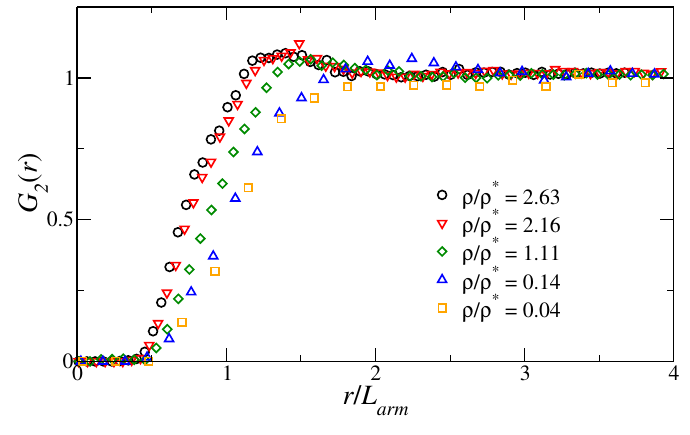
Figure 2. Radial distribution function of the centers of mass of the DNA tetramers as function of the inter-particle distance r , measured in units of the average arm length L arm , at fixed temperature T = 25 ◦ C and salt concentration S = 0.5 M, for different reduced densities ρ / ρ ∗ .